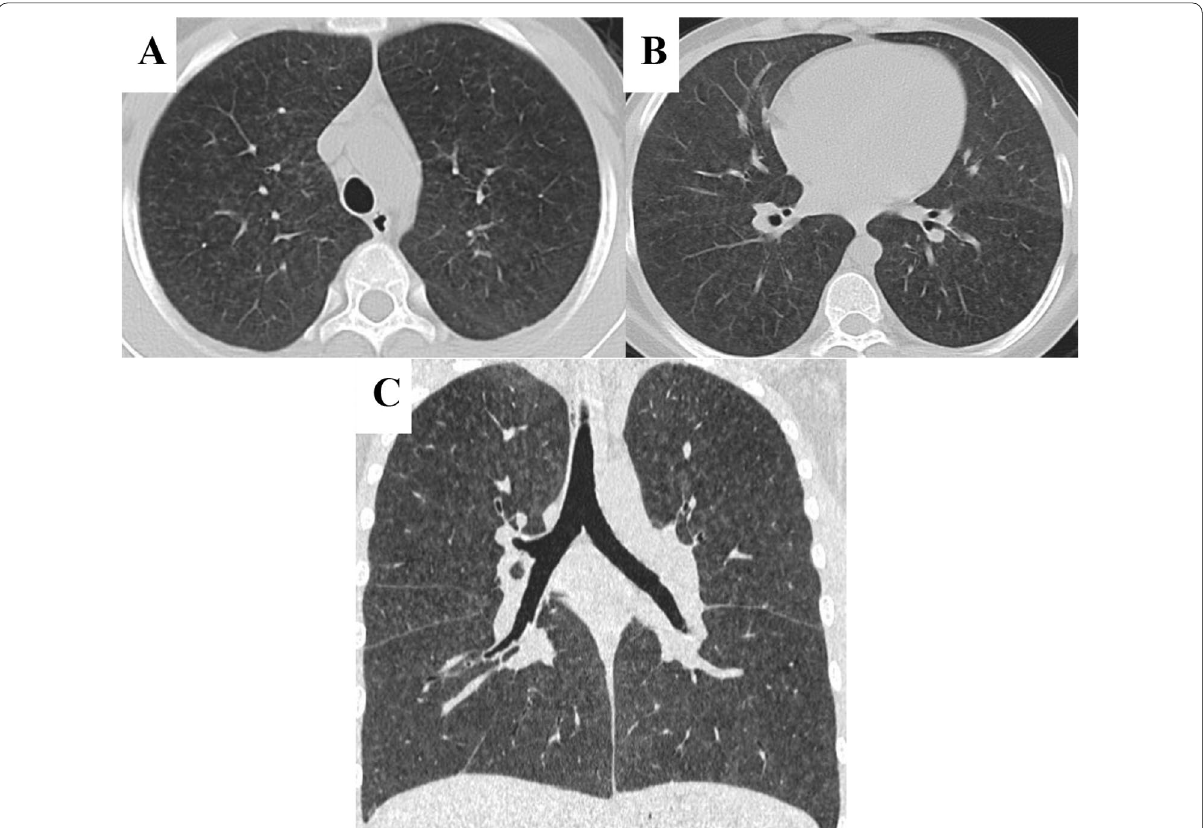
Fig. 9 A 25-year-old male complaining of hemoptysis. HRCT of the chest in a, b axial and c coronal lung window images showing bilateral diffuse ill-defined centri-lobular and peri-lymphatic nodules. Lung biopsy was taken and revealed alveolar